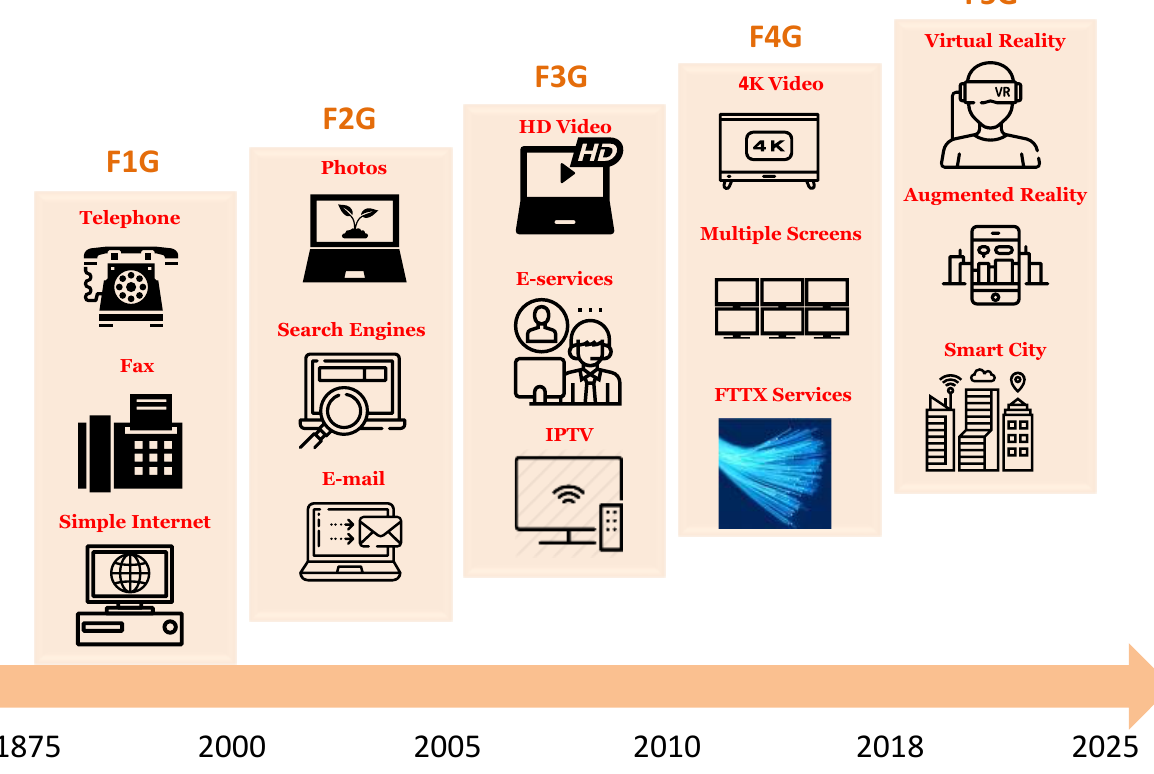
Figure 2. Representative services over the five fixed network generations.